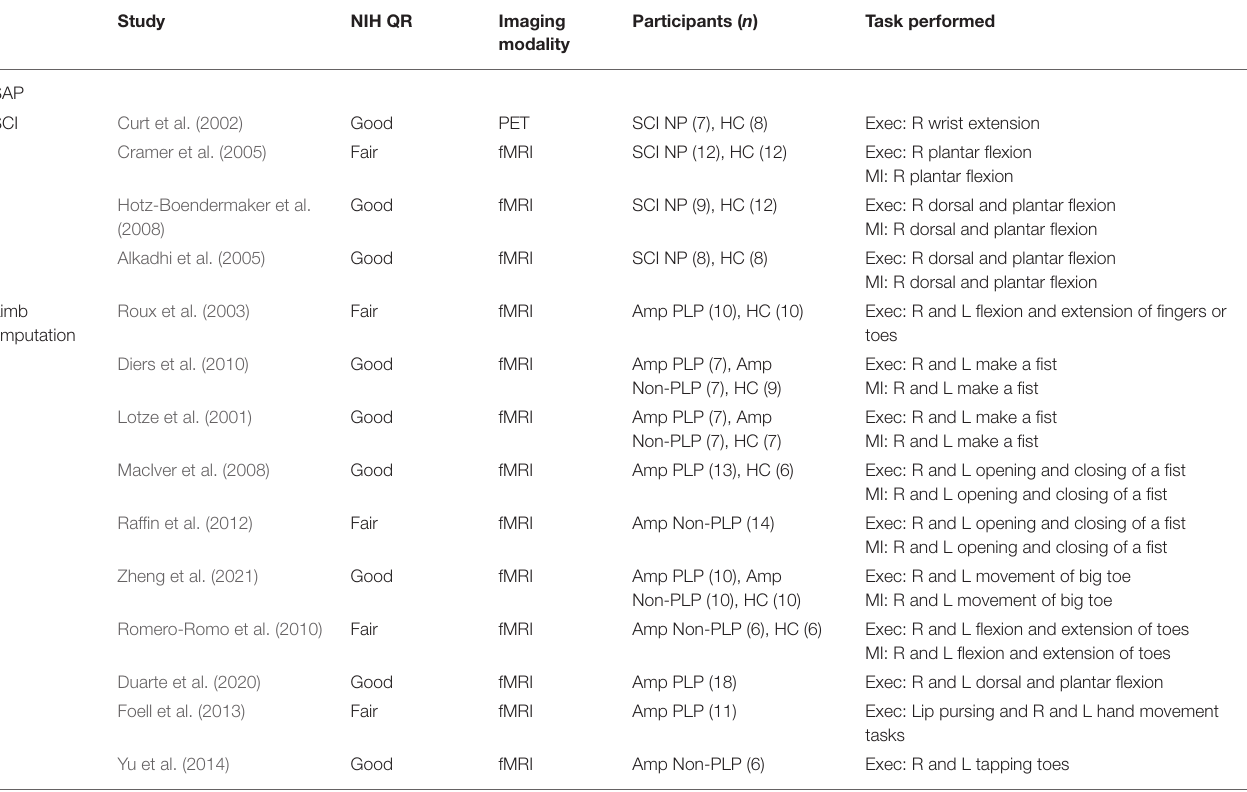
TABLE 4 | Characteristics of studies included in the meta-analysis measuring cortical activity during movement imagery and movement execution in SAP. Study NIH QR Imaging Participants ( n ) Task modality